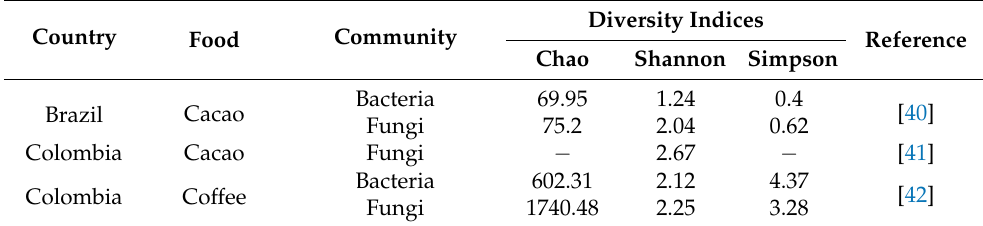
Table 1. Diversity indices of fermented cacao and